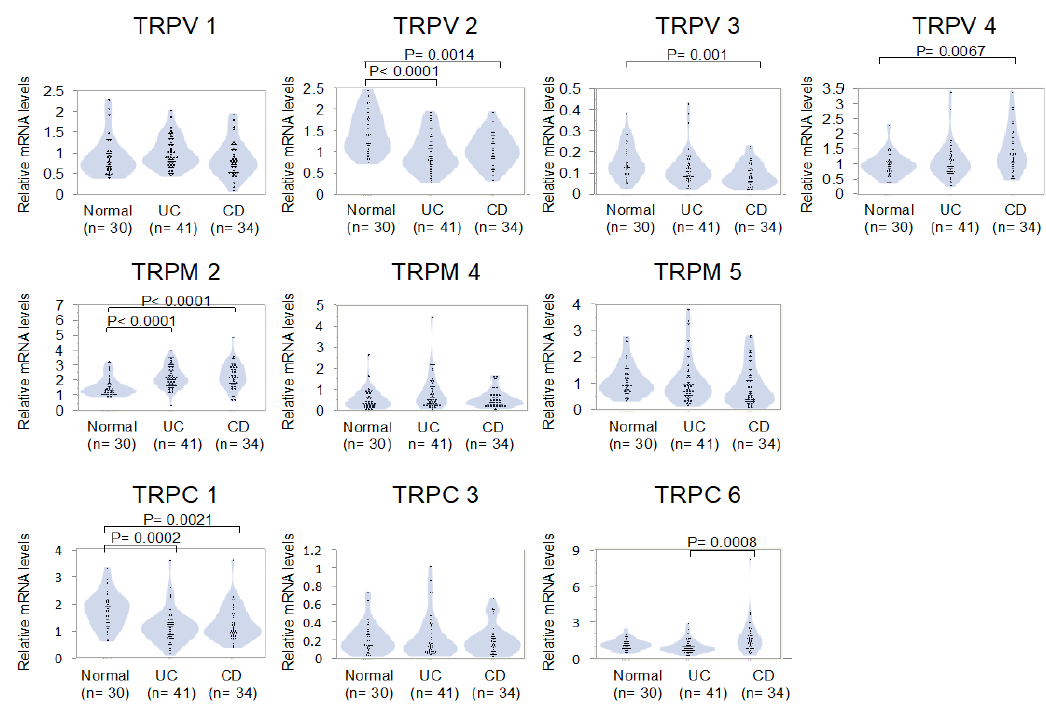
Figure 1. Expression of transient receptor potential (TRP) channels in healthy subjects, patients with ulcerative colitis (UC) and Crohn’s disease (CD). Bars represent mean ± SD. N: Number of subjects. Inter-group significance, Bonferroni-corrected Mann–Whitney U test, p < 0.01. Further, TRPC6 mRNA expression was higher in the CD group (1.68 ± 1.41 (1.79-fold), p = 0.0008) than in the UC group (0.94 ±